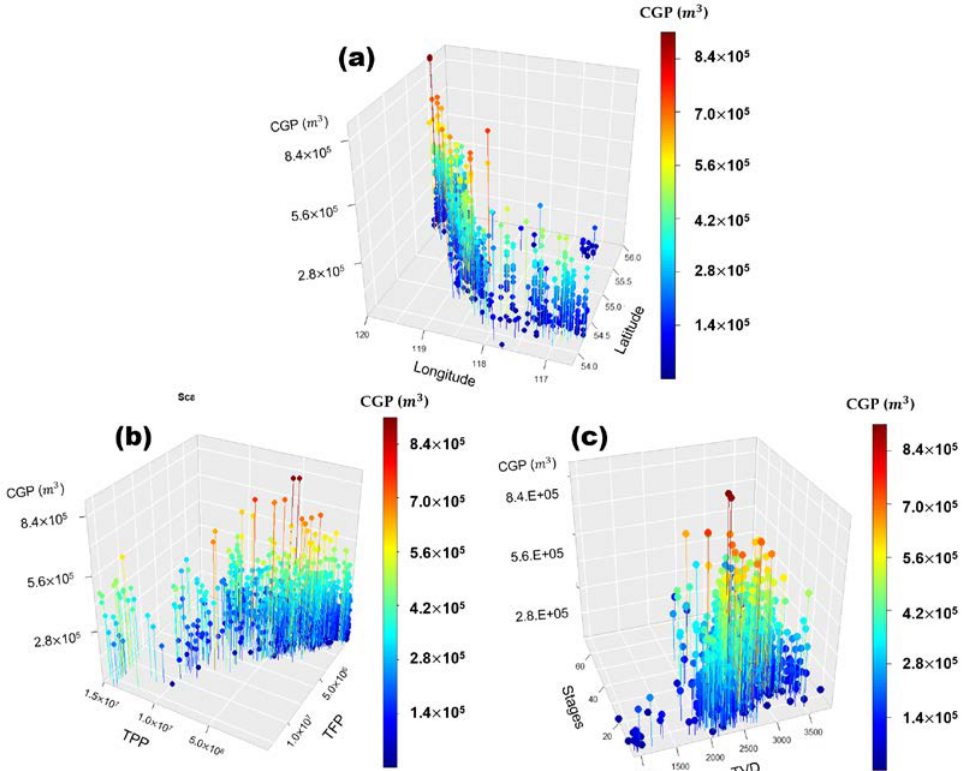
Figure 7. 3D plots graph of cumulative gas production over 12-months relationship to ( a ) longitude and latitude; ( b ) total proppant placed and total fluid pumped; ( c ) Stages and total vertical depth.